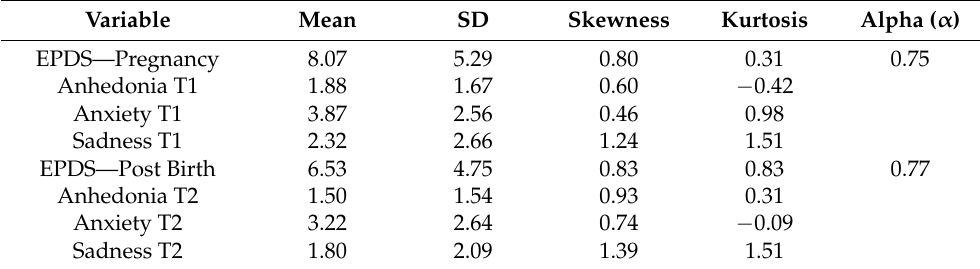
Table 2. Edinburgh Depression Scale descriptive statistics, pregnancy and